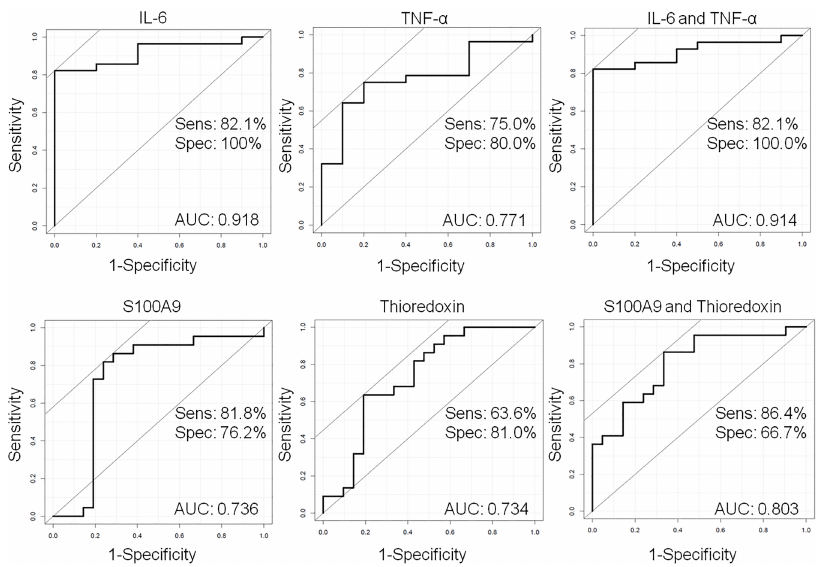
Fig 4. Estimation of predictive power of possible biomarkers using ROC curve analysis. The sensitivity (y axis) was plotted versus 1 − specificity (x axis) in case of each potential biomarker alone or in combinations. The area under the curve is indicatedon each pane. The sensitivity and specificity was calculatedfor each biomarkers and biomarker combination.